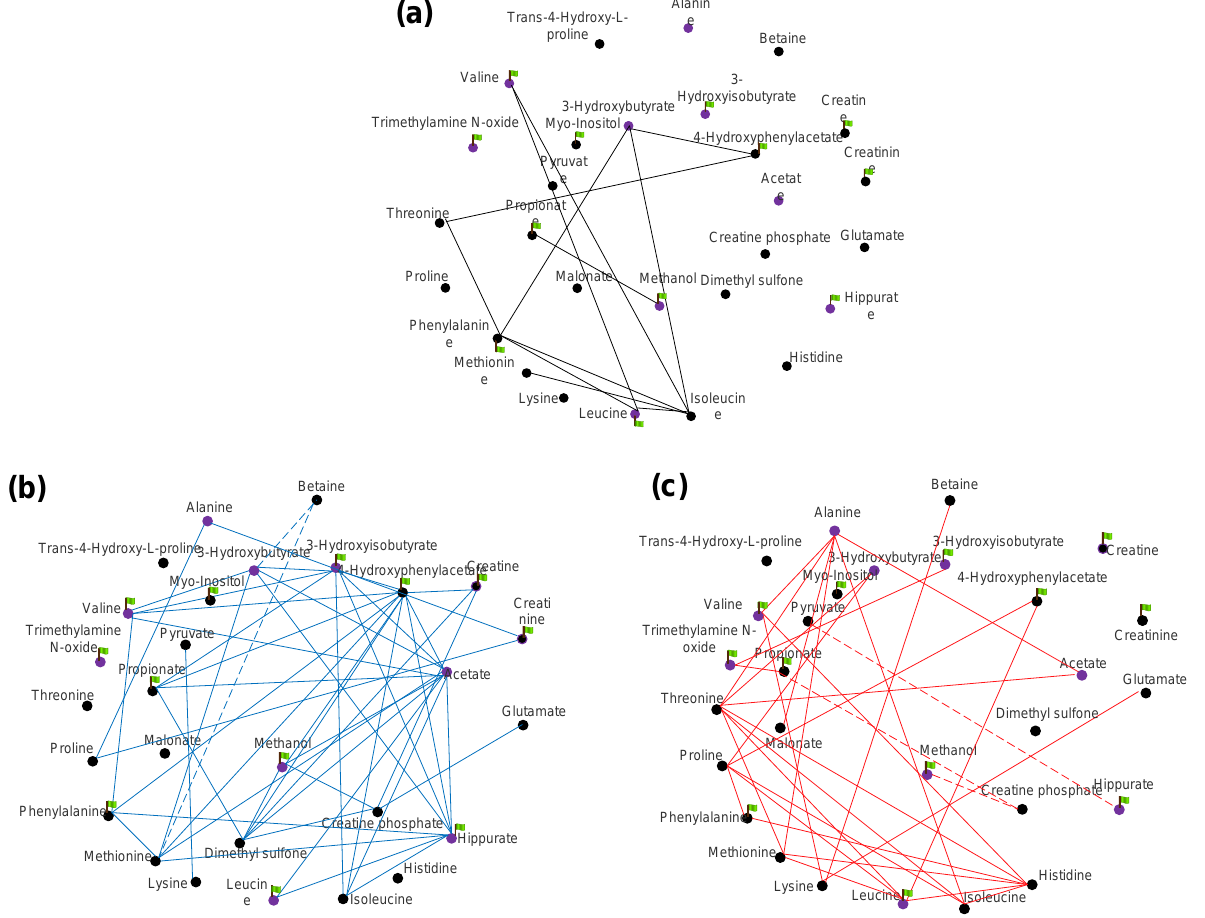
Figure 6. Correlation-based networks of 28 metabolites in Sanhe cattle. ( a ) The correlation among metabolites that were common in the serum of Sanhe cattle before and after severe cold stress. ( b ) The correlation among metabolites that were only found in the serum of Sanhe cattle before severe cold stress. ( c ) The correlation among metabolites that were only found in the serum of Sanhe cattle after severe cold stress. The solid line is significantly positive correlated, while the dotted line is significantly negative correlated. The purple circles are the metabolites with a VIP value > 1 in PLS-DA, and the green flags are the metabolites with a p -value < 0.05 in the paired t